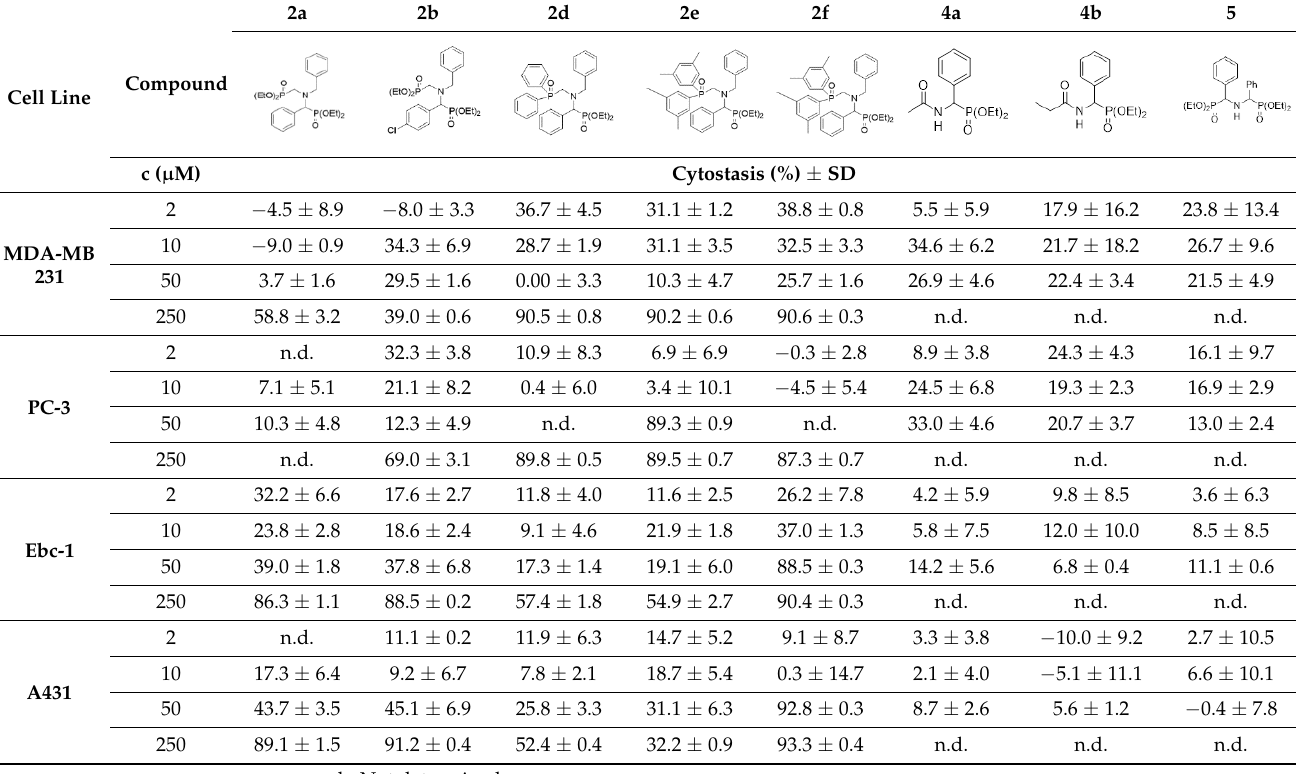
Table 2. Cytostatic effect of α-aminophosphonic derivatives compounds on human tumor cell lines. Cells were treated for 24 h and then cultured for another 72 h. Cell viability was determined with an MTT assay, and the percent of cytostasis was calculated.